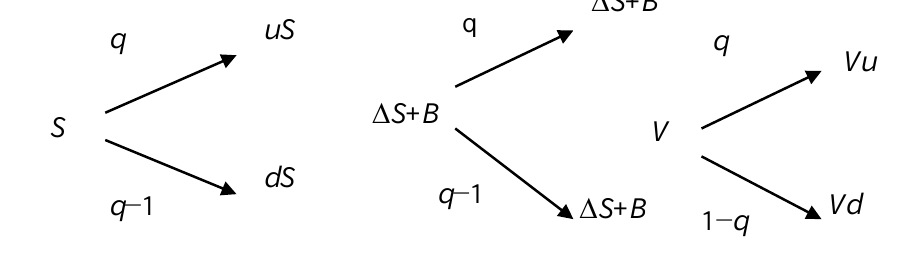
Fig. 1. The binomial